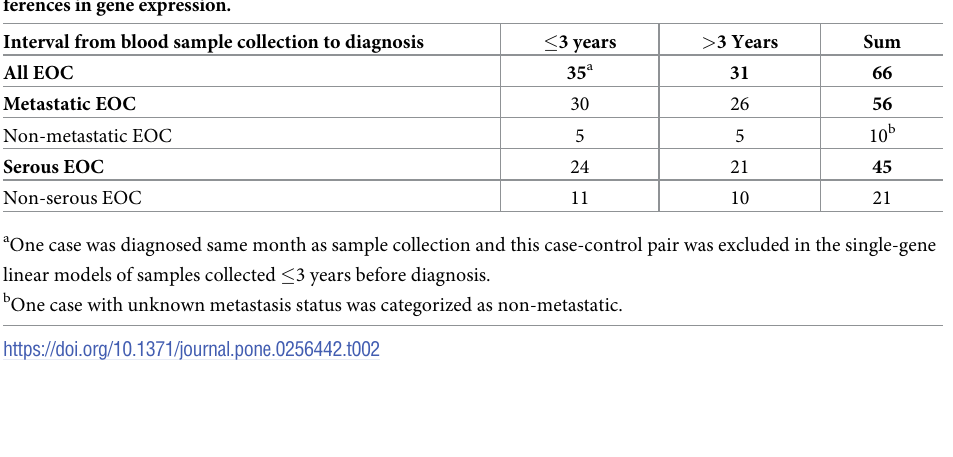
(n = 45), which constituted 68% of all EOC (24 with blood sample collected � 3 years and 21 collected > 3 years before diagnosis) (Table 2). Among serous EOC, the percentage of high, low, and unknown grade was 69%, 4%, and 27%, respectively. Of the high-grade serous EOC, 40% and 60% had blood samples collected � 3 years and > 3 years before diagnosis, respec- tively. Among those with low- and unknown-grade serous EOC, the corresponding distribu- tions were 50% and 50%, and 60% and 40%, respectively. Compared to controls, cases had larger estimated mean fractions of CD8+ T cells and plasma cells (p = 0.08 and p = 0.07, respectively), and smaller fractions of neutrophils, monocytes, and resting mast cells (p = 0.06, p = 0.08, and p = 0.02, respectively; S1 Table).